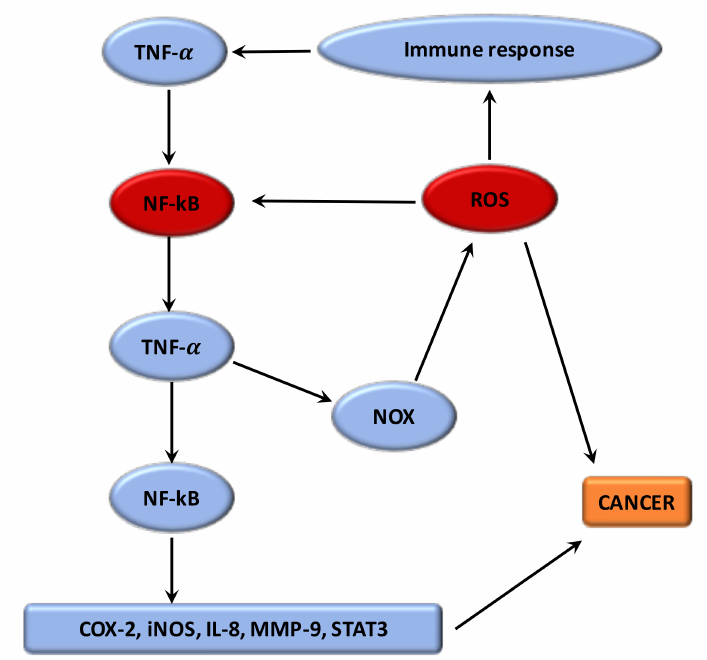
Figure 1. Relationship between ROS and chronic inflammation. The imbalance caused by oxidative stress leads to damage in the signaling in cells. ROS have a key role both upstream and downstream of the NF- κ B and TNF- α signaling pathways, which are the main mediators of the inflammation. A vicious circle is observed between ROS and these pathways. ROS are generated by the NOX system. Proteins modified by ROS could result in activation of the auto-immune response to stimulate TNF- α and thus NOX. The dysregulation of these targets leads to the activation of several pathways involved in cancer